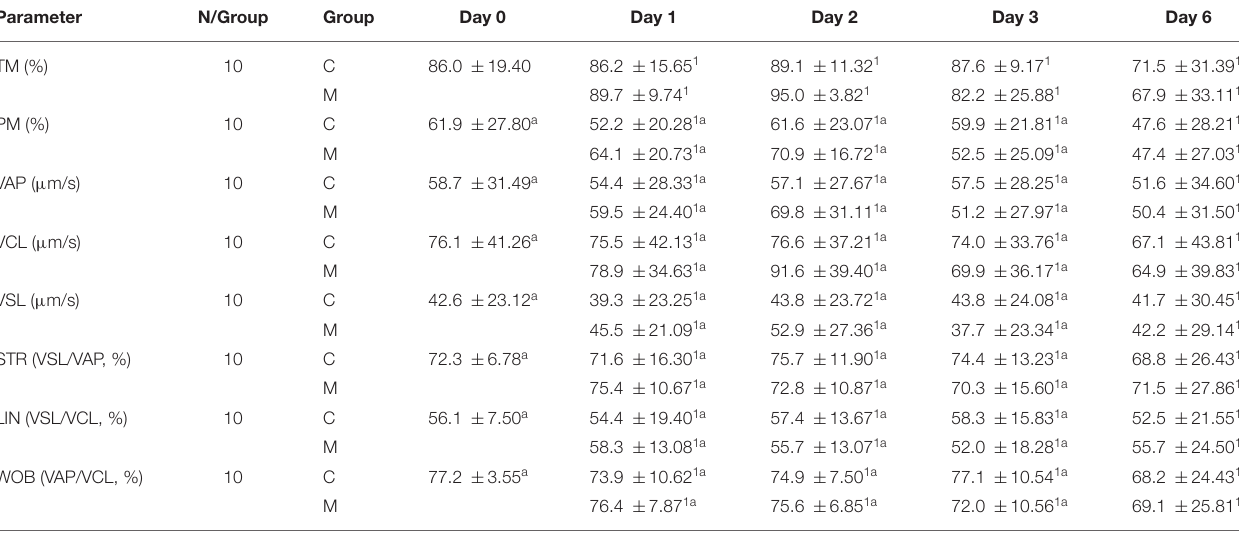
TABLE 3 | Results from CASA motility parameters from semen samples collected in decreasing photoperiod during a cold storage period of 6 days.